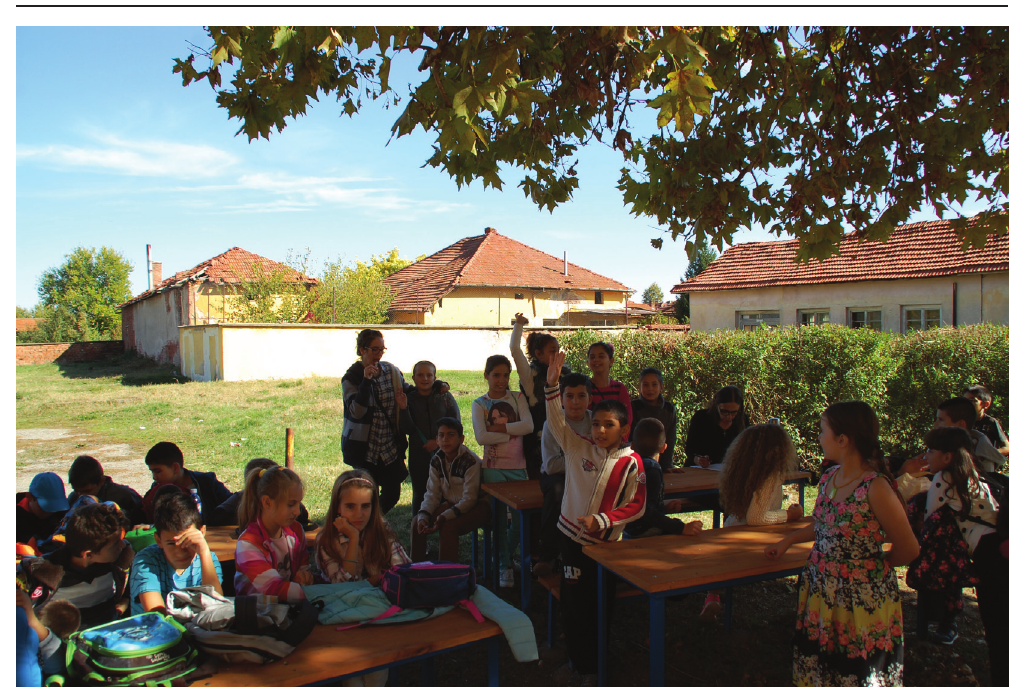
Figure 5: Discussion after a screening of The Spirit of the Beehive (1973, directed by Víctor Erice), held with students from primary school 98, Saints Cyril and Methodius,